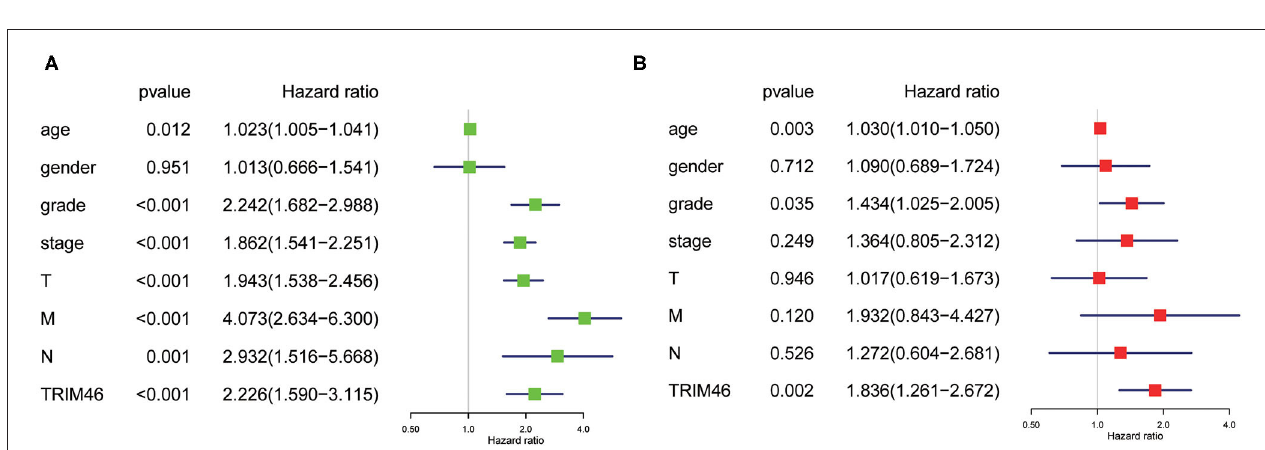
FIGURE 3 | (A) Univariate Cox regression analysis. (B) Multivariate Cox regression